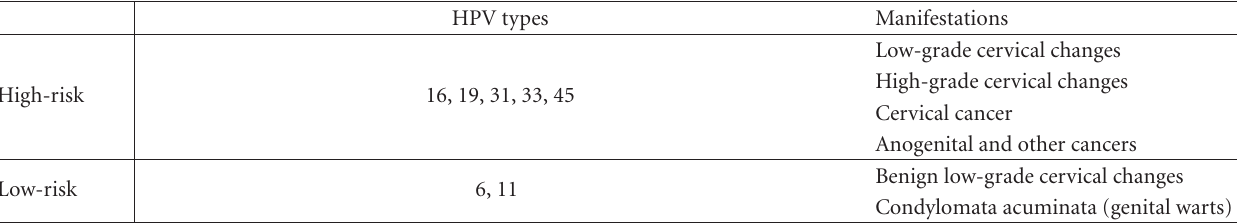
Table 1: Common HPV types associated with HPV-related diseases